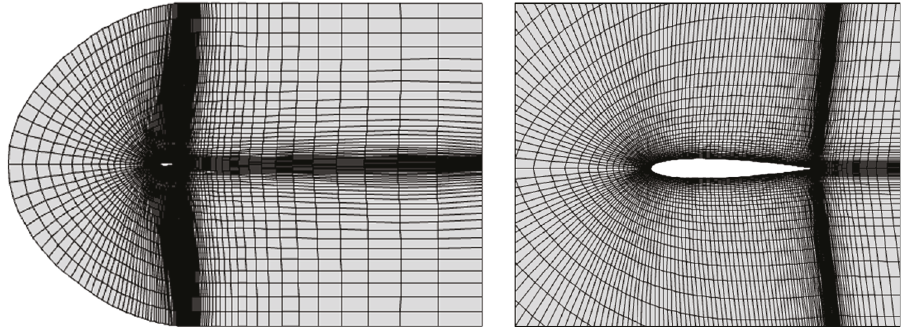
Figure 1: Structured mesh for NACA 0012 airfoil.